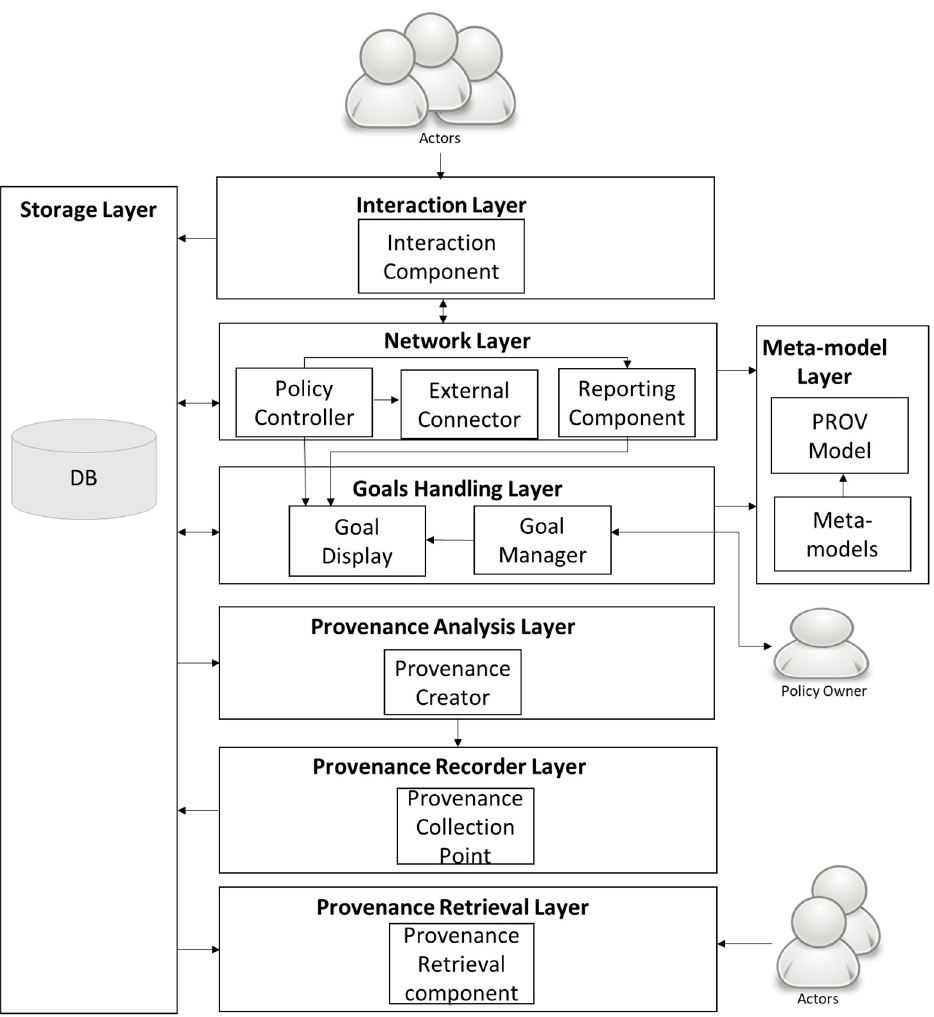
Figure 7. Policy Cycle Provenance Architecture.